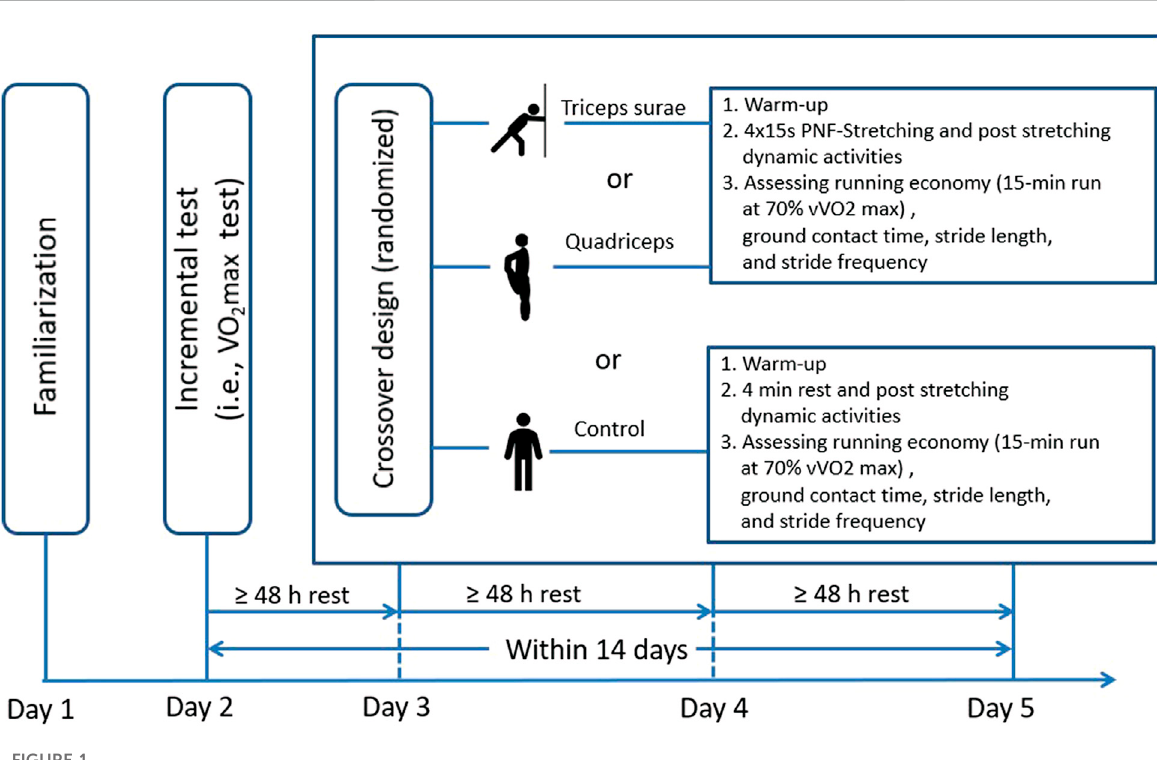
FIGURE 1 Schematic schedule of the